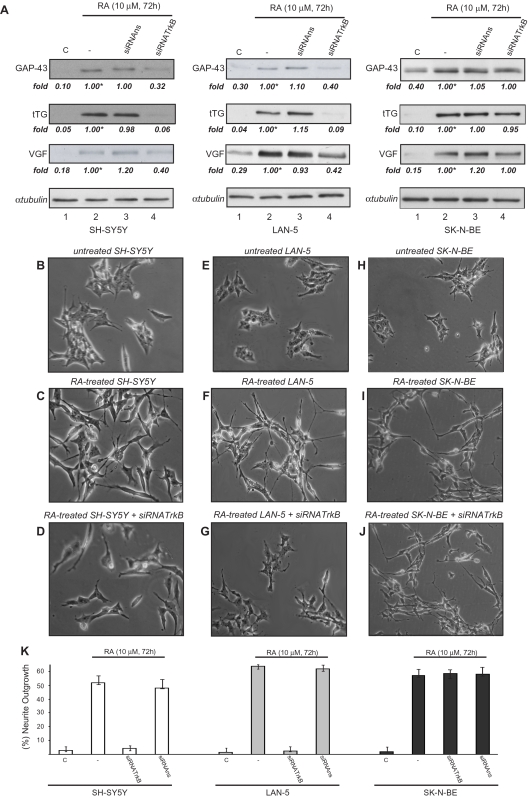
TrkB mediates the RA-dependent differentiation in SH-SY5Y and LAN-5.SH-SY5Y (left panels), LAN-5 (middle panels) and SK-N-BE (right panels) cells were left untreated or treated with RA in the absence or in the presence of siRNATrkB or the negative control siRNAns, as indicated. (A) Cell lysates were immunoblotted with anti-GAP-43, anti-tTG or anti-VGF antibodies. Equal loading was confirmed by immunoblotting with anti-αtubulin antibodies. Quantitation and relative abundances are expressed relative to controls, arbitrarily set to 1 (see legend to Figure 1A). Blots shown are representative of at least four independent experiments. (B) to (K): Following RA-treatment, the percentage of neurite outgrowth was calculated and reported as histogram (K). Data are percentage of neurite bearing cells/total cells analyzed. Columns, average of three independent experiments. Microphotographs of cells are shown (B to J).